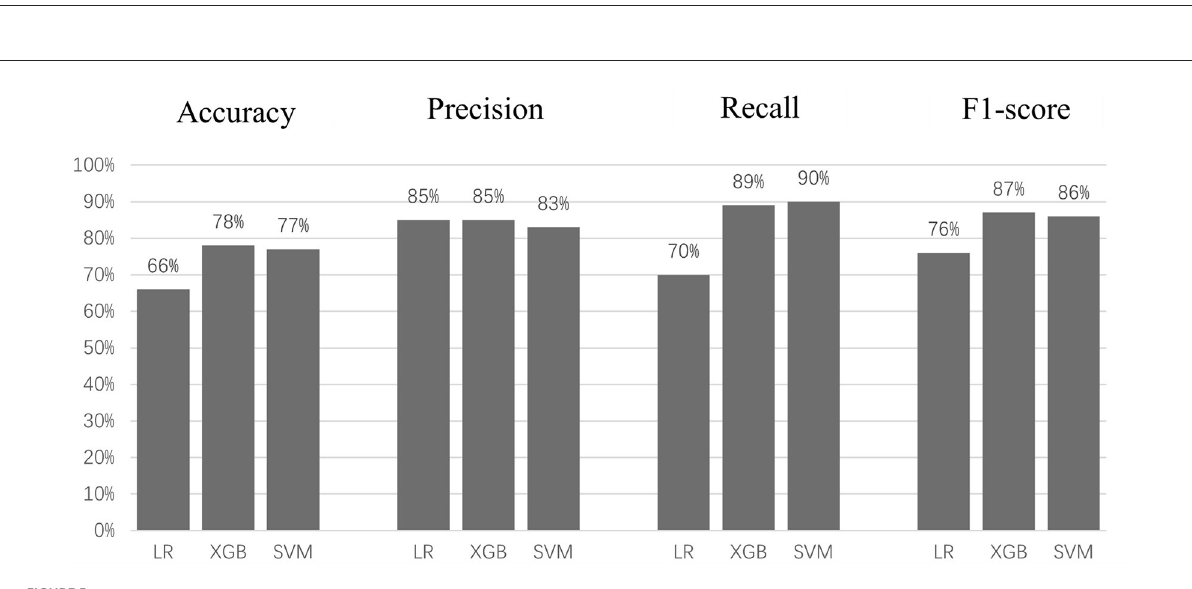
FIGURE5 Accuracy, precision, recall, and F1 score for each